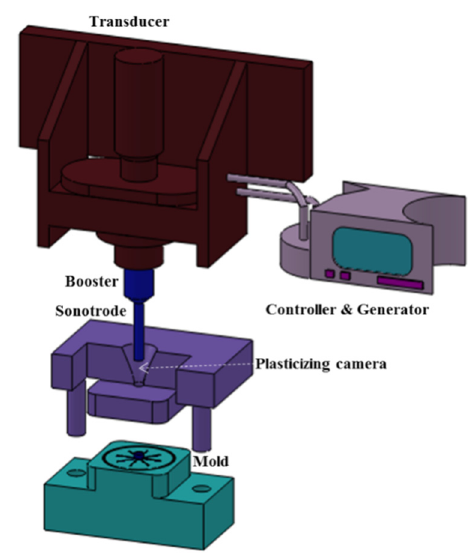
Figure 1. Scheme of the main parts of the micromolding equipment.